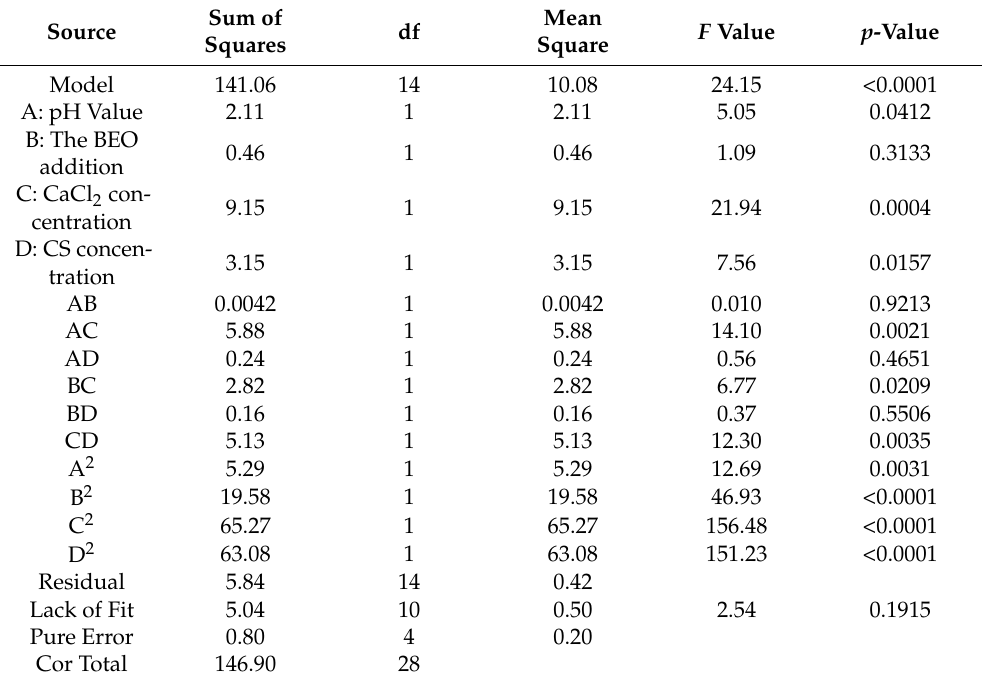
Table 8. ANOVA for the response surface quadratic